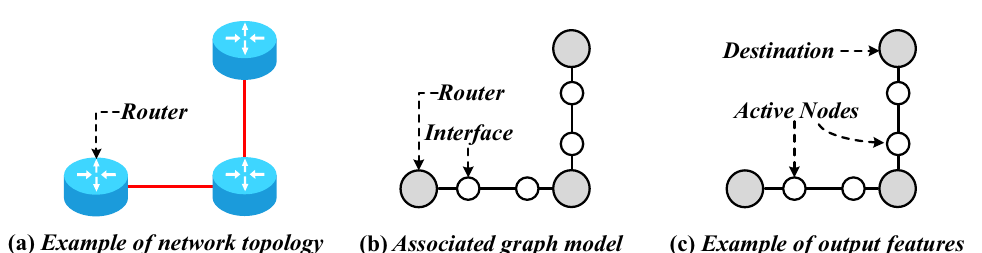
Figure 7. ( a ) Example network topology. ( b ) Its associatedgraph used for training. ( c ) The output feature of the inter-faces according to a selected destination 56